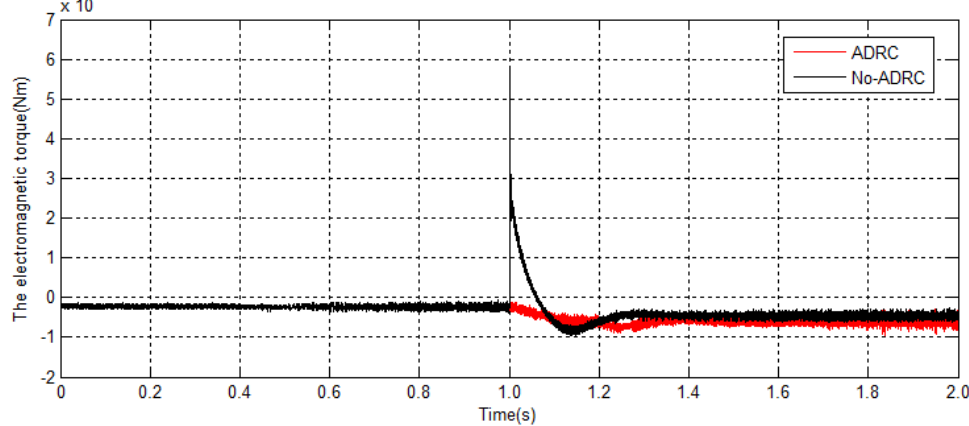
Figure 17. Simulation curve of the electromagnetic torque.